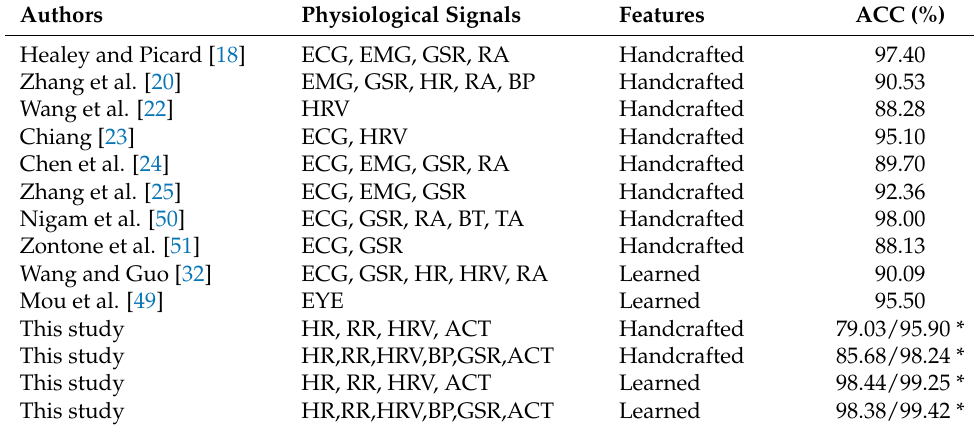
Table 7. Comparison of the achieved results with the state of the